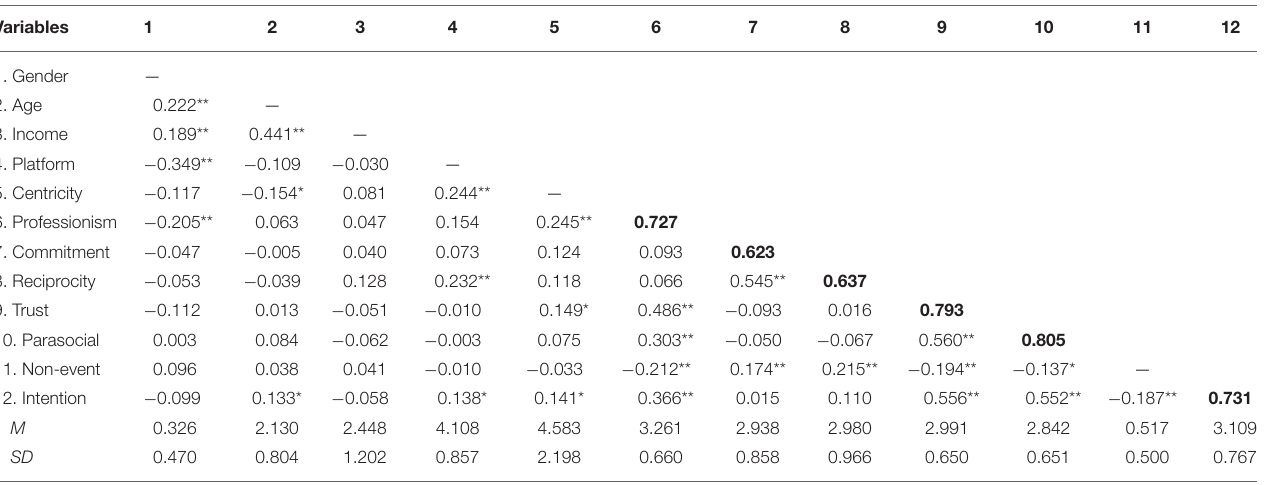
TABLE 2 | Descriptive statistics and correlation coefficients of the variables.